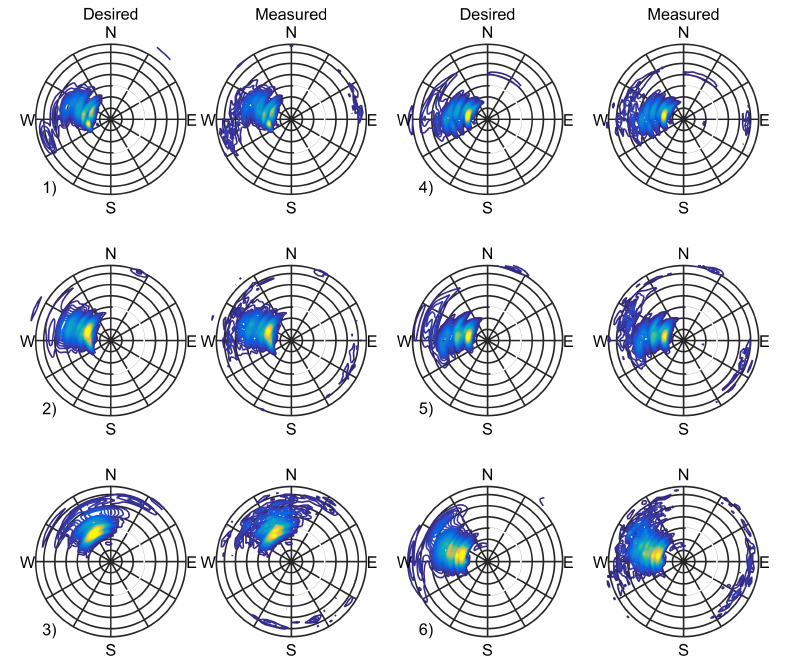
Figure 12. SPAIR method directional spectrum outputs for the example extreme spectra. Total output directional spectra shown, including reflections. Energy densities are shown by the colour scale and are normalised by the maximum of the desired spectrum for each sea state. 1 ) to 6 ) correspond to sea states 1 to 6 defined in Table